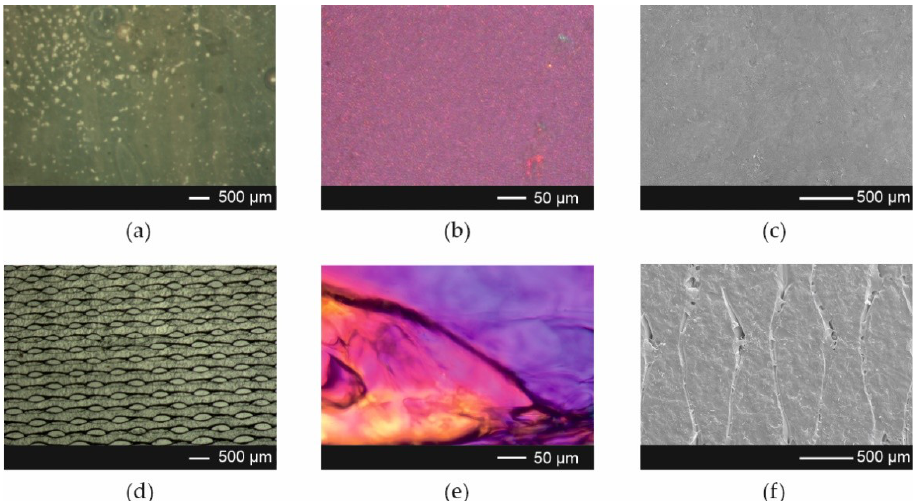
Figure 3. Microphotographs of the Cast ODFs (upper panel) and 3D ODFs (lower panel) ( a , d ) visible light image; ( b , e ) polarized light image; ( c , f ) SEM image at magnification 50×.